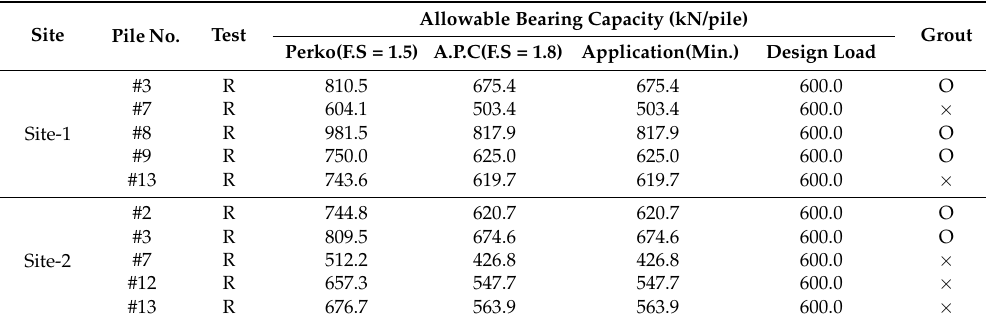
Table 3. Results of the dynamic pile load test for each